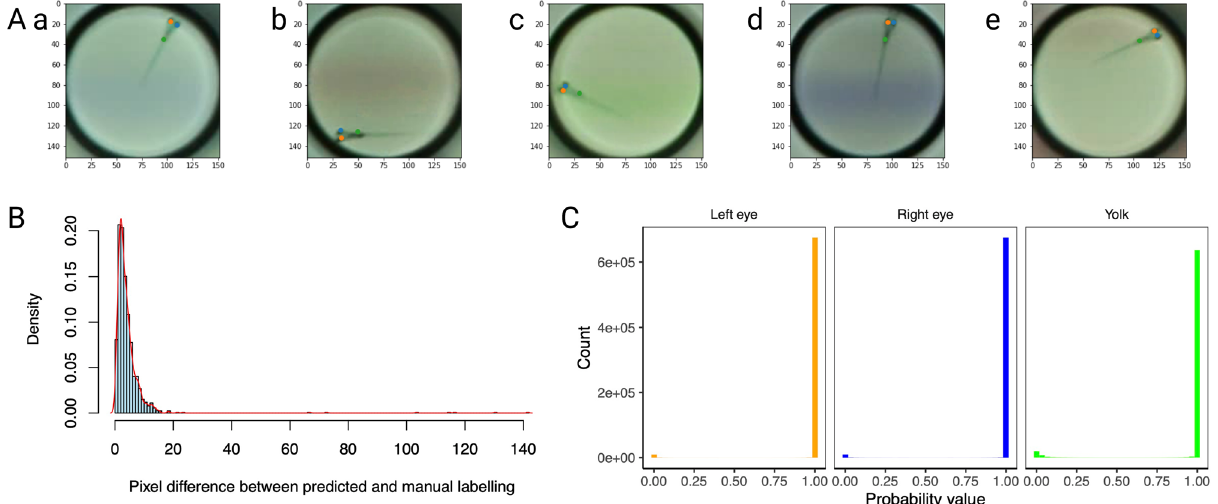
Figure 2. Validation of model: ( A ) The trained DeepLabCut model can detect the left eye (orange dot), right eye (blue dot), and yolk (green dot) across diverse backgrounds such as blank ( Aa ), red moving lines ( Ab ), green moving lines ( Ac ), blue moving lines ( Ad ) and fast red moving lines ( Ae ). ( B ) Euclidean distances between predicted and manually labeled features are described as histograms. The pixel difference between the predicted and manual labeling shifts towards lower pixel difference values after training the model. ( C ) The detection probability of a trained model to accurately detect the left eye (orange bar), right eye (blue bar), and eye (green bar) are shown. The model detects each of the features with very high probability values (=